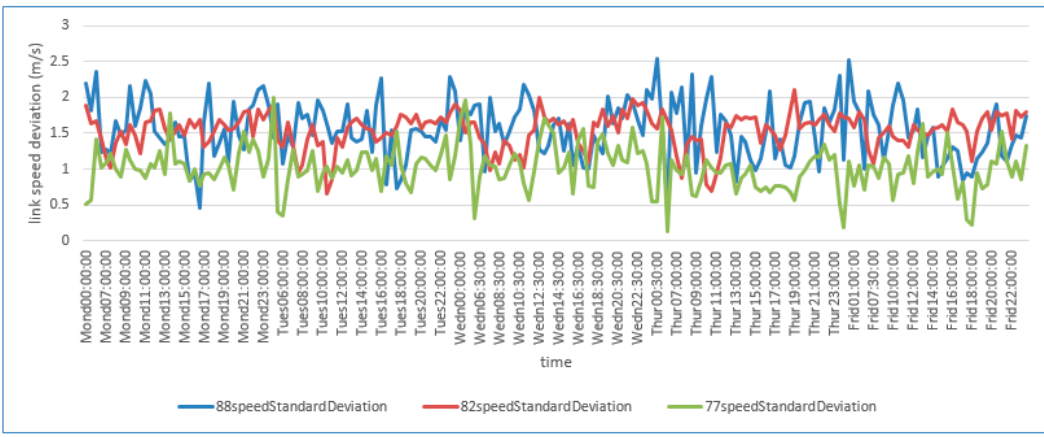
Figure 4. Line chart of speed standard deviation among link 77, link 82, and link 88.